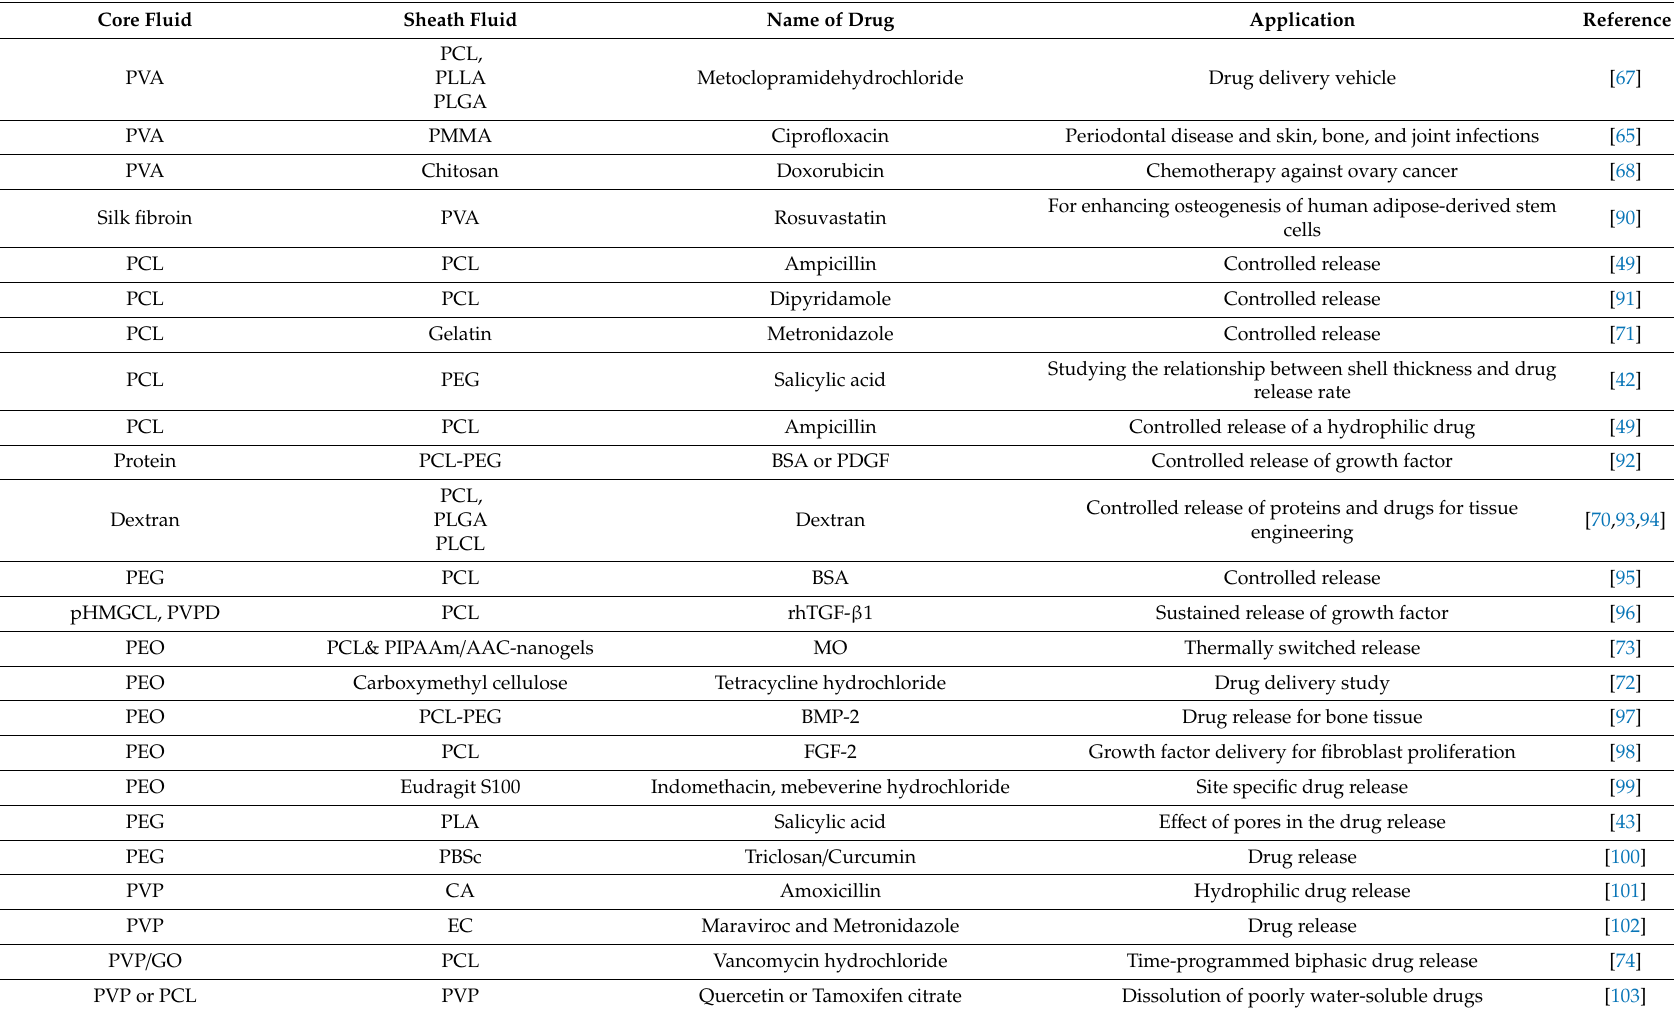
Table 2. Various core-sheath nanofibers for drug delivery